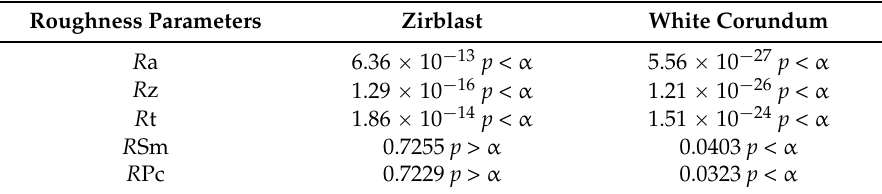
Table 8. p ‐ Values at different pressure.